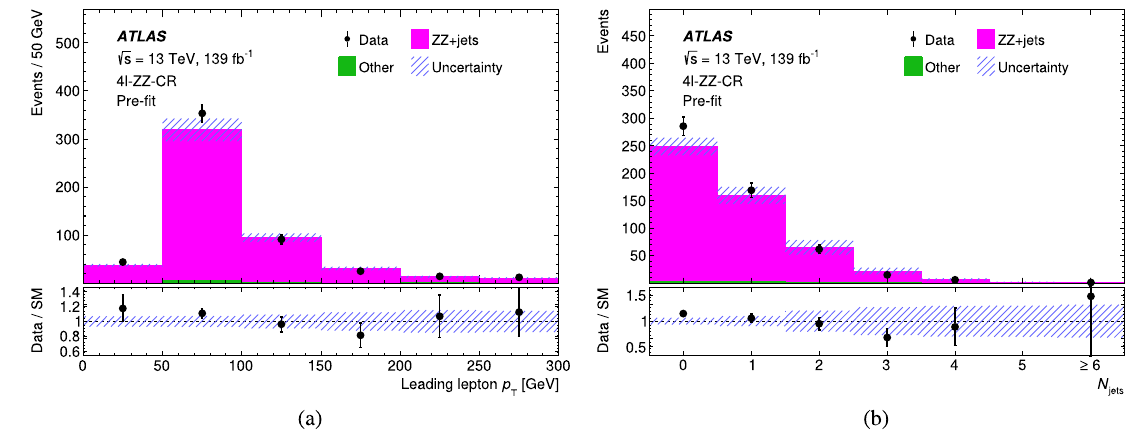
Fig. 2 Distribution of a the p T of the leading lepton and b the number of selected jets in the Z Z + jets control region. The shaded band cor- responds to the total uncertainty (systematic and statistical) of the total SM prediction. The lower panel shows the ratio of the data to the SM